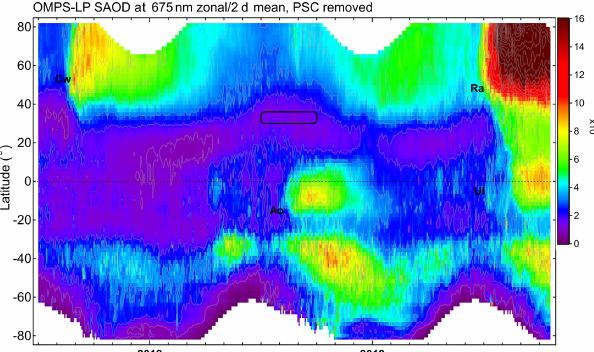
Figure 9. Time–latitude distribution of zonal-mean and 2d mean lower-stratospheric aerosol optical depth at 675nm between the tropopause and 21km of altitude from July 2017 to October 2019, as calculated from OMPS LP satellite data. The tropopause alti- tude for each OMPS LP profile was provided within the OMPS LP dataset. Signals due to polar stratospheric clouds (PSCs) have been removed. Major events that significantly enhanced NH stratospheric aerosol loading are labelled: Cw, Canadian wildfires in the summer of 2017; Ao, Ambae (Aoba) eruption, Vanuatu (July 2018); Ra, Raikoke eruption, Kuril Islands, Russia (June 2019); Ul, Ulawun eruption, Papua New Guinea (July, August, and October 2019) (GVP, 2013). The rectangular box indicates the period and location of the lidar measurements; white regions indicate missing measure-